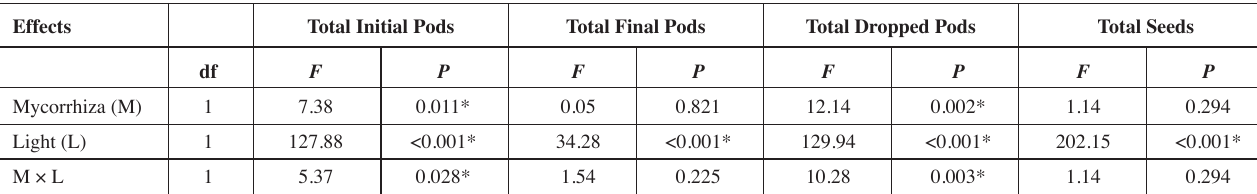
Tab. 2: Summary of ANOVA results of the effects of mycorrhizal fungi and light availability on reproductive plant traits. Effects